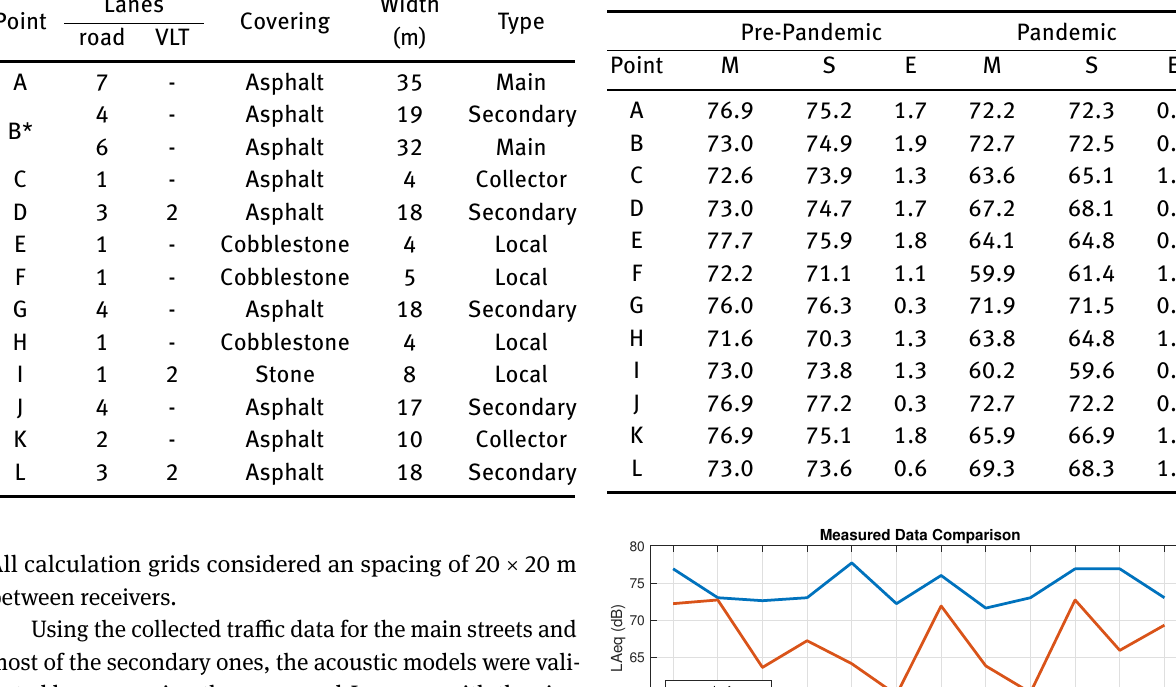
Table 1: Street characteristics at the evaluation points. (*) Point B is at the corner of two main streets